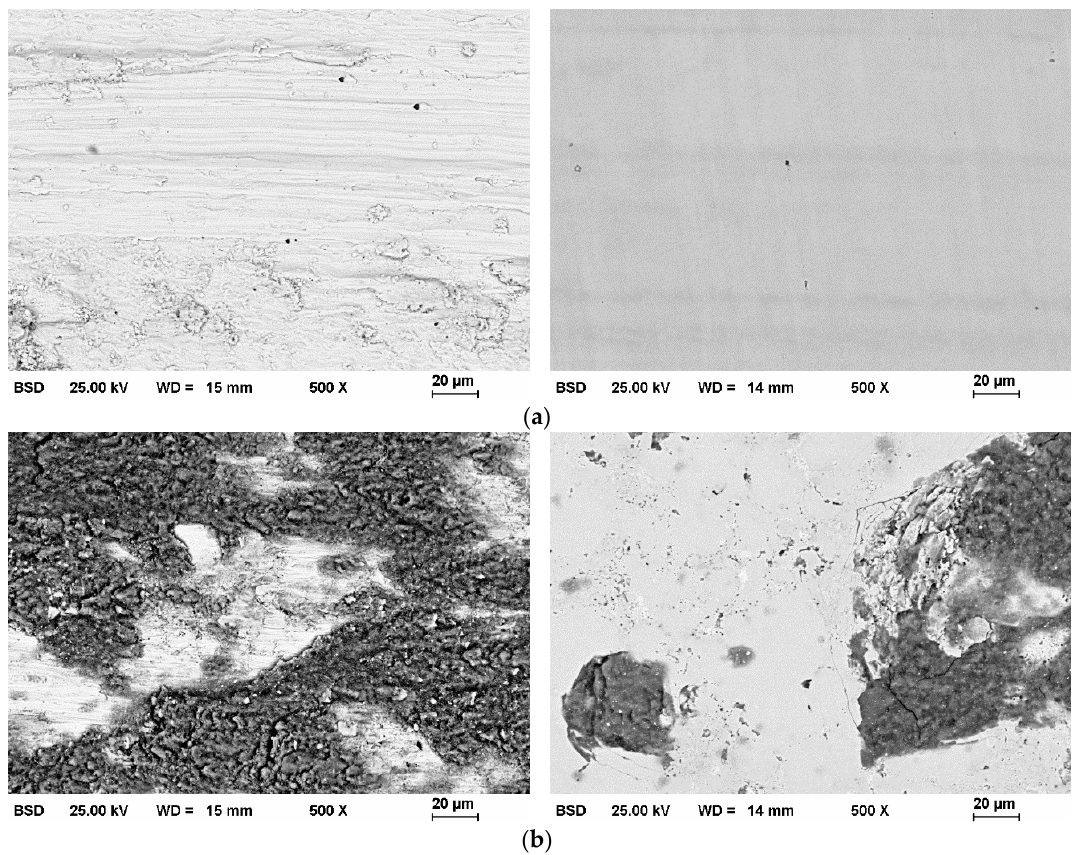
Figure 6. SEM images (BSD) of CrFeCoNi surface in untreated (left) and borided (right) state after ball-on-disk test: ( a ) casting and ( b ) HVOF coating.